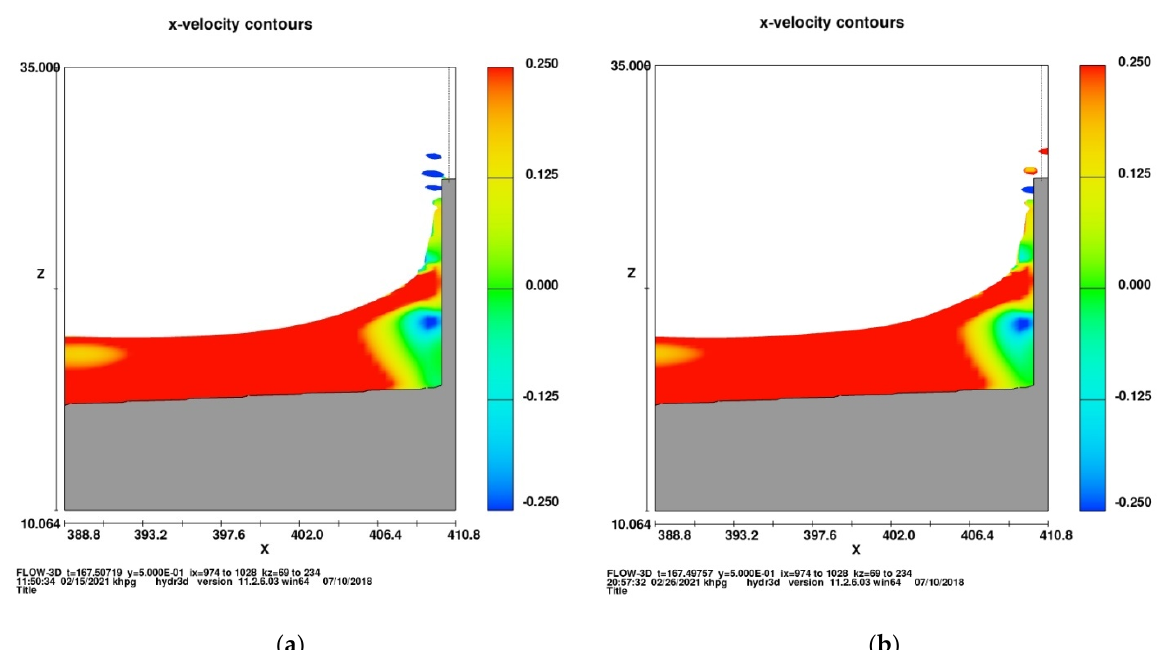
Figure 16. TEST_3 and Rc = +10.00 m. Panel ( a ) no wind; panel ( b ) U10 19 m/s.